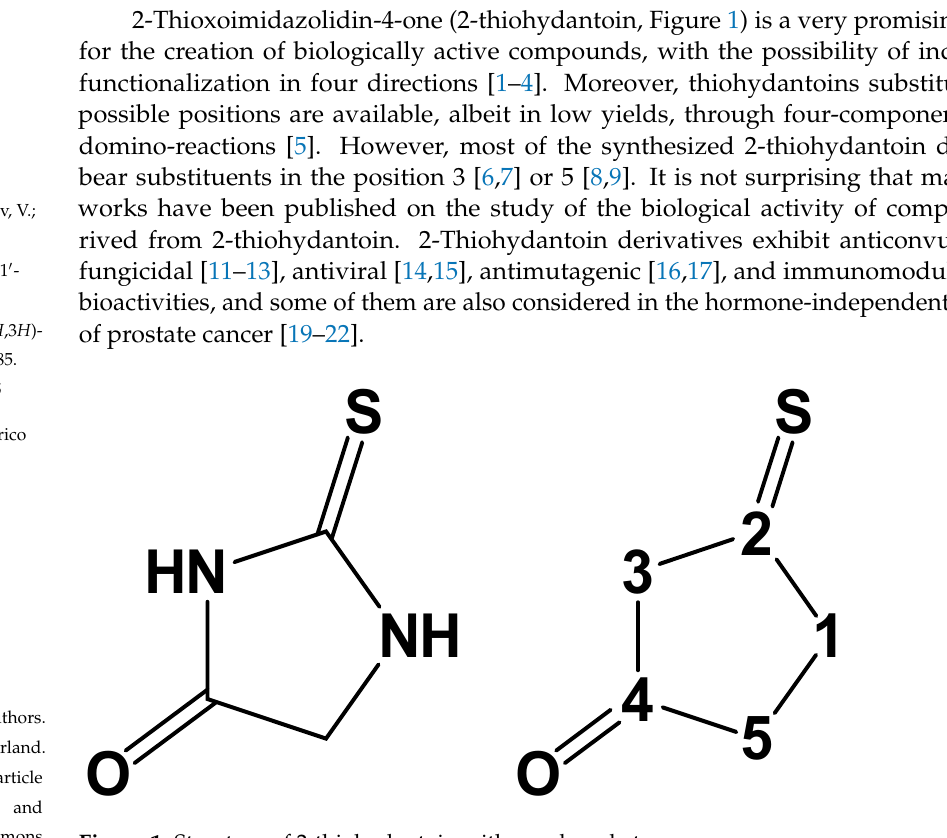
Figure 1. Structure of 2-thiohydantoin with numbered atoms.